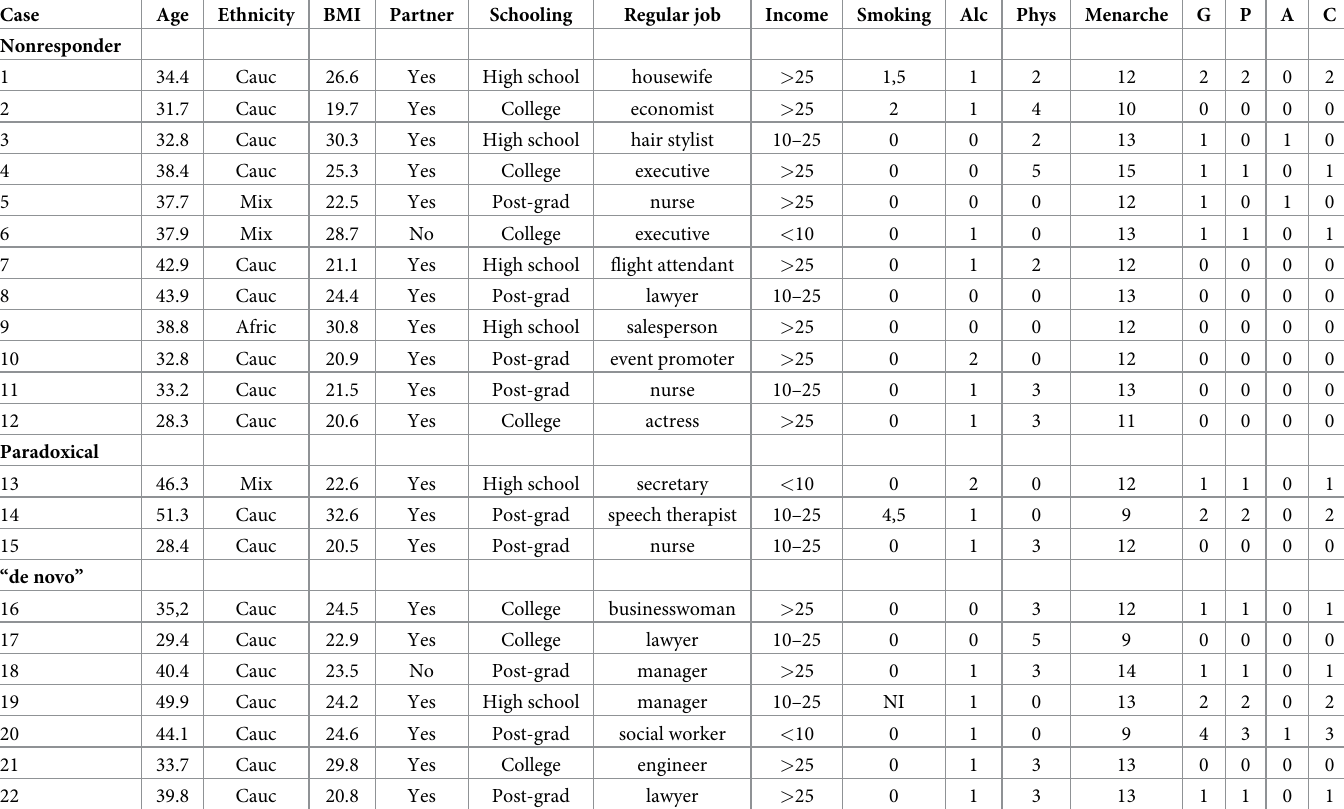
Table 2. Demographic characteristics, personal habits and obstetric history of the 22 women who were not considered responders for deep